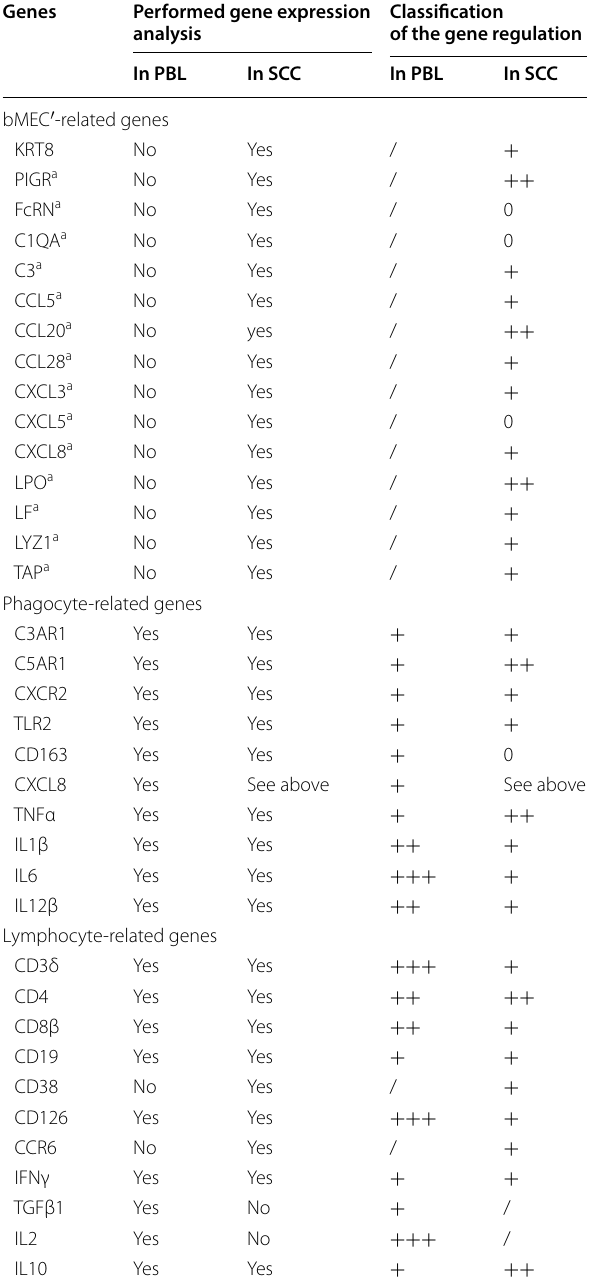
Table 2 Spectrum of genes analyzed in PBL and in SCC out of milk and the classification of their